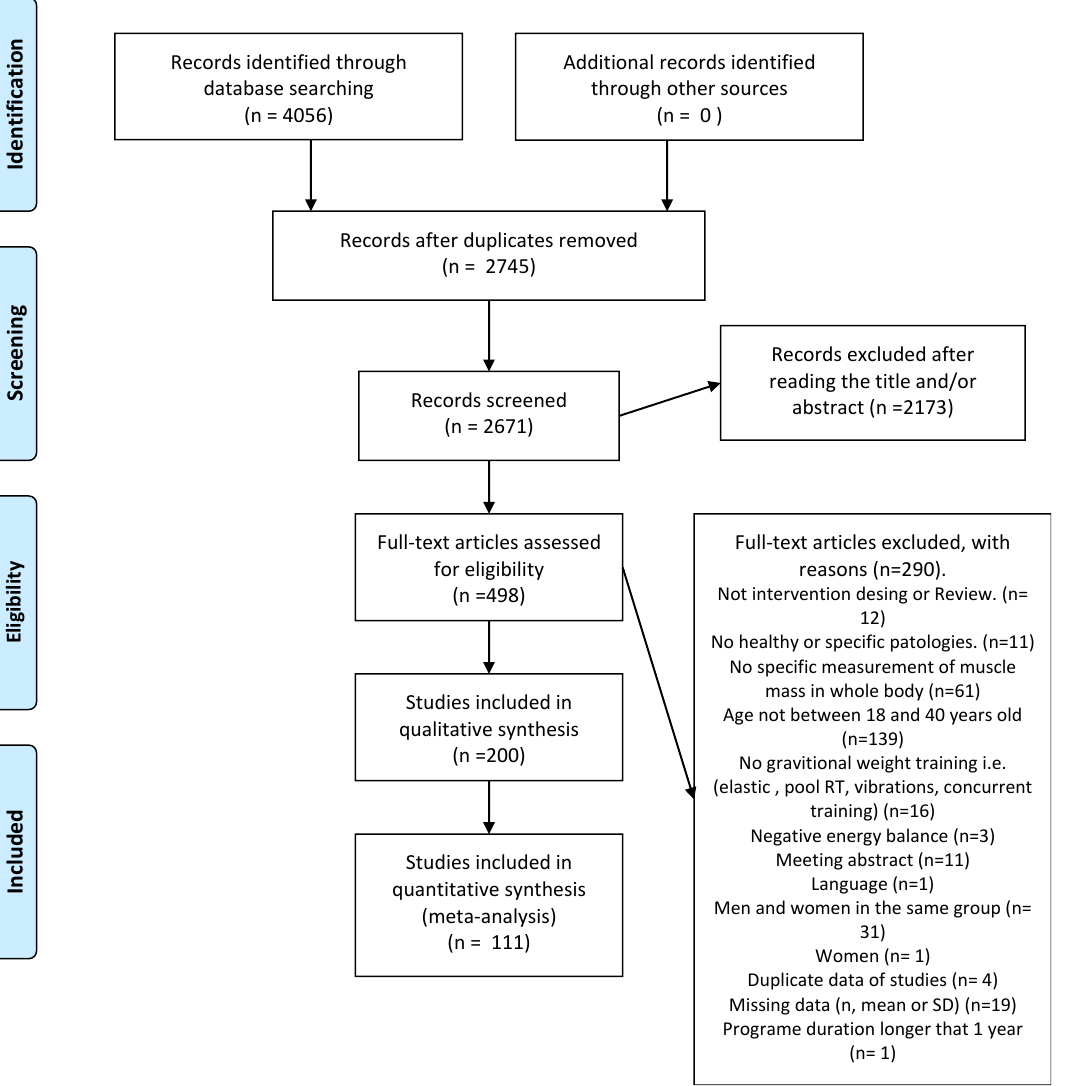
Figure 1. Prisma flow diagram for the included studies.